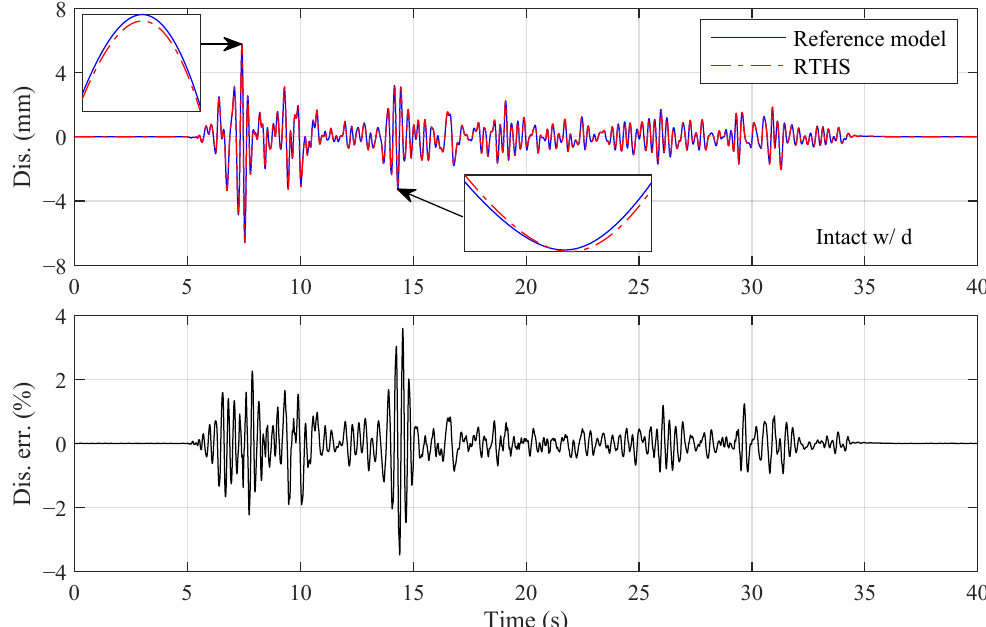
Figure 15. Third-floor displacement responses of Intact w/ d (El Centro earthquake, Case 4, perturbed